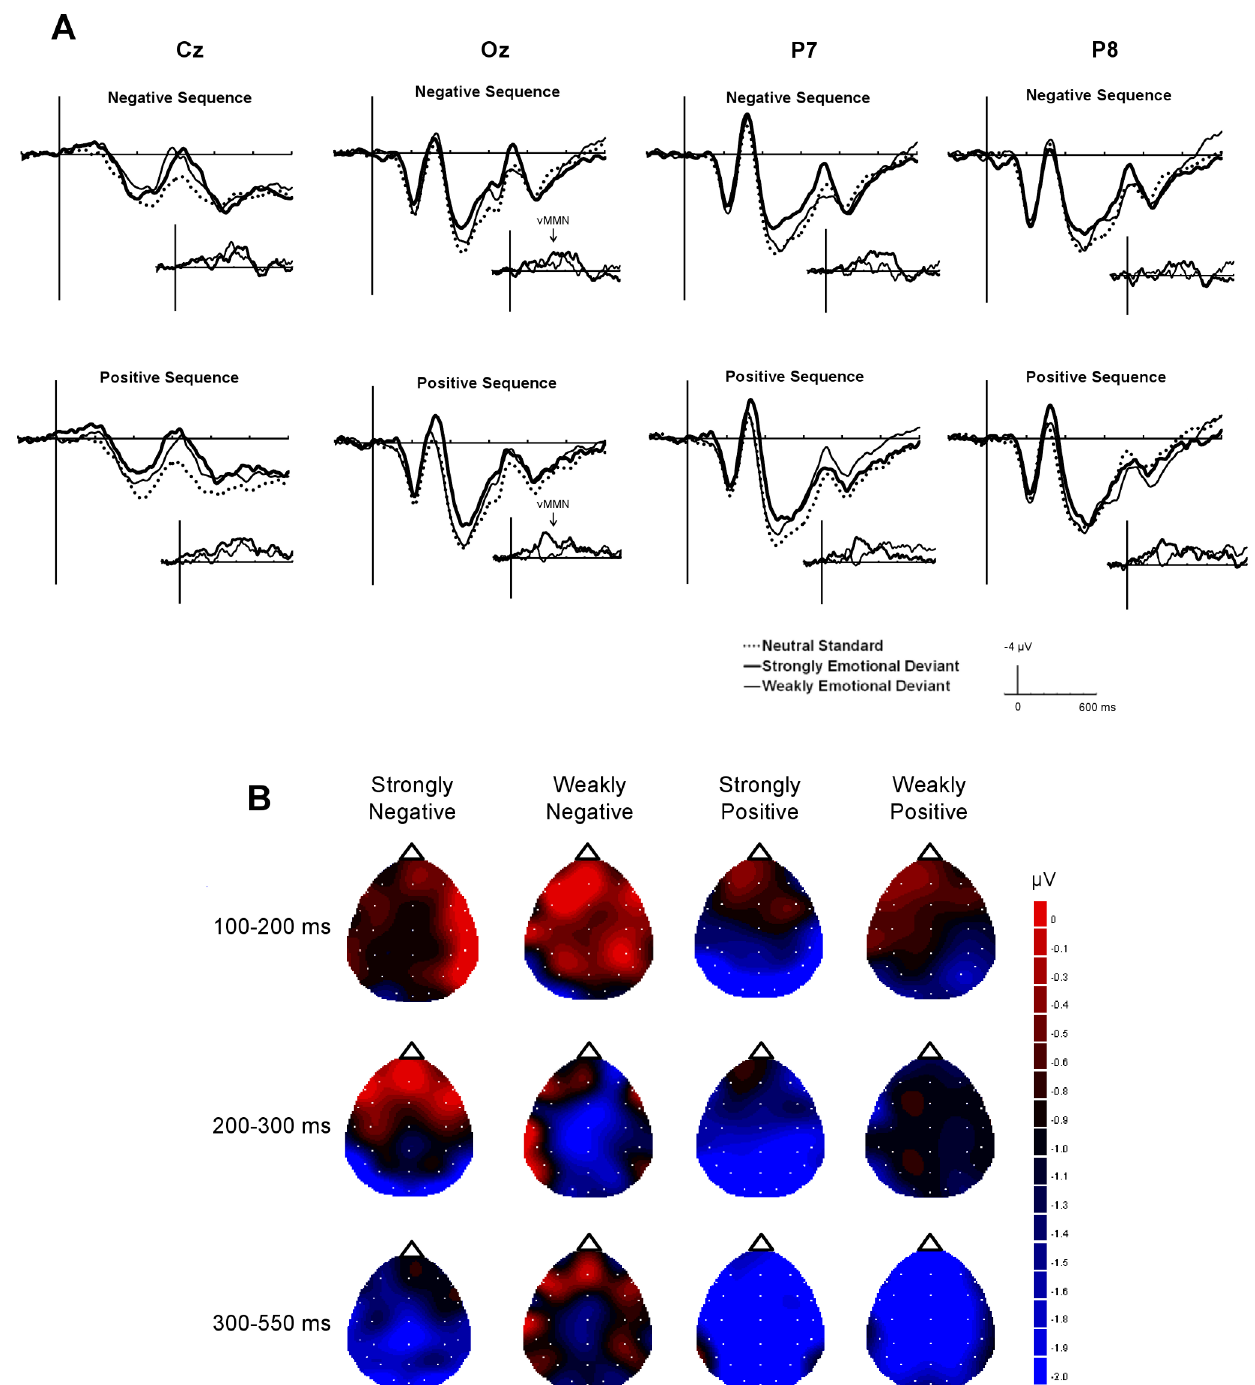
Figure 2. ERP results in Experiment 1. (A) The grand-average ERPs at Cz, Oz, P7, and P8 elicited by standards (dashed line), strongly emotional deviants (bold line), and weakly emotional deviants (thin line) in negative and positive sequences. The inset shows vMMN, grand average deviant- minus-standard, for strongly emotional deviants (bold line) and weakly emotional deviants (thin line). (B) The topographies of the voltage difference between the standards and the deviants at the peak latencies for each time period. The images have been flattened into a two-dimensional space using the global interpolation method, which uses all electrodes to calculate values at any given point, viewed from the top of the head. doi:10.1371/journal.pone.0063703.g002 stimulus type ( F (2,46) = 7.54, p , .01). Multiple comparisons using the Tukey-HSD test showed that the amplitude for strongly emotional deviants shifted more negatively than that for standards used for the ANOVAs. A three-way ANOVA for the ERP ( HSD = 0.66, a = .05). A significant three-way interaction was also amplitudes at 100–200 ms revealed a significant main effect of